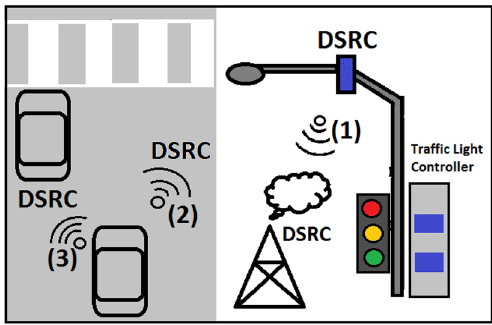
Figure 4. TL, RSU, and vehicle communication using